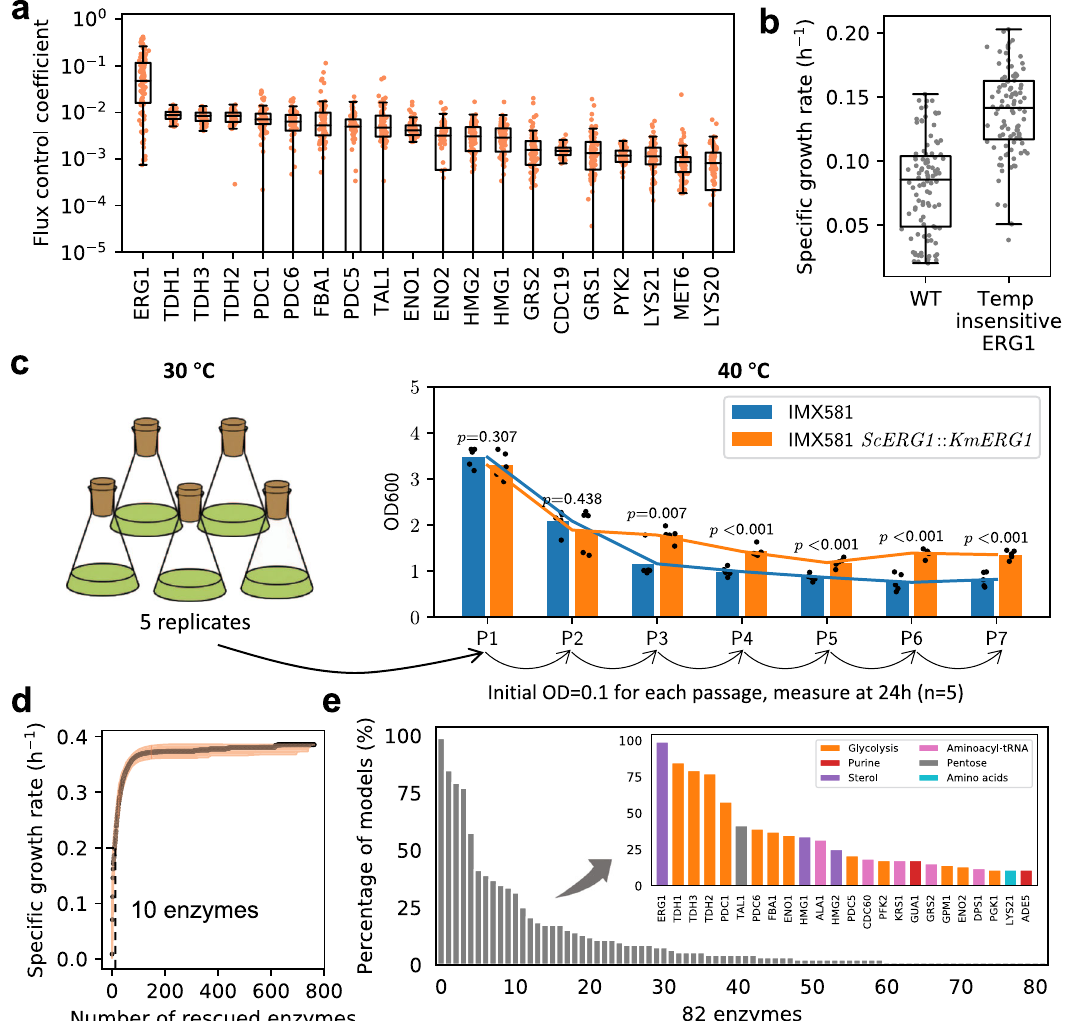
Fig. 5 etcGEM uncovers growth rate-limiting enzymes. a Twenty enzymes with the highest fl ux sensitivity coef fi cients at 40 °C ( n = 100 for each enzyme). b Predicted maximal speci fi c growth rate of wild-type yeast and the one without any temperature constraints (fully functional) on ERG1 enzyme at 40 °C ( n = 100 for each strain). In a , b , centerline, median; box limits, upper and lower quartiles; whiskers, 1.5× interquartile range; Each dot represents the prediction from one Posterior etcGEMs. c The effect of KmERG1 expression on thermotolerance in S. cerevisiae . The strains were passaged for 7 times (24 h for each passage) to obtain stable growth at 40 °C. Optical densities (600 nm) are shown at 24 h. Data are represented as mean values of fi ve replicates in the bar chart. Dots represent the values of fi ve replicates. p Values denote Welch ’ s t test (two-sided). The exact p values for P1 – P7 are 0.307, 0.438, 0.0066, 0.00020, 0.00046, 0.00015, 0.00018, respectively. d Simulated maximum speci fi c growth rate by removing the temperature constraints of most rate-limiting enzymes at each step in each Posterior etcGEM at 42 °C. Lines indicate median values and shaded areas indicate the region between the 5th and 95th percentiles ( n = 100). e The percentage of Posterior etcGEMs ( n = 100) predicts an enzyme to be in the minimal enzyme set required